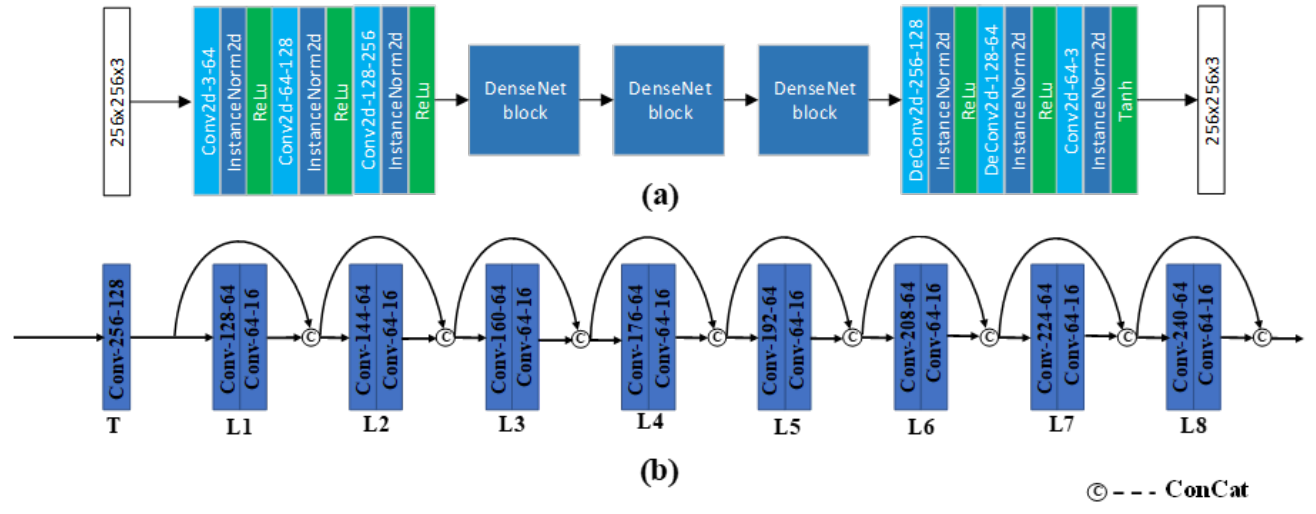
Figure 4. Architecture of the generator and DenseNet blocks networks. ( a ) Generator network structure and ( b ) DenseNet block, where “Conv” denotes the convolution layer and “Deconv” denotes the deconvolution